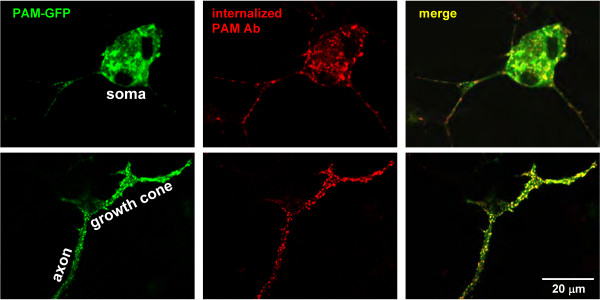
LDCV secretion occurs throughout neurons. Neurons were transfected with vector encoding PAM-GFP. After 2 days in culture, cells were stimulated with PMA in the presence of PAM ectodomain antibody for 15 min; internalized antibody was subsequently visualized in fixed, permeabilized cells with a Cy3 conjugated secondary antibody. Internalized PAM antibody was detected throughout the cell soma (top), along processes (bottom) and at growth cones (labeled). In the absence of secretagogue, almost no antibody uptake was observed (not shown).